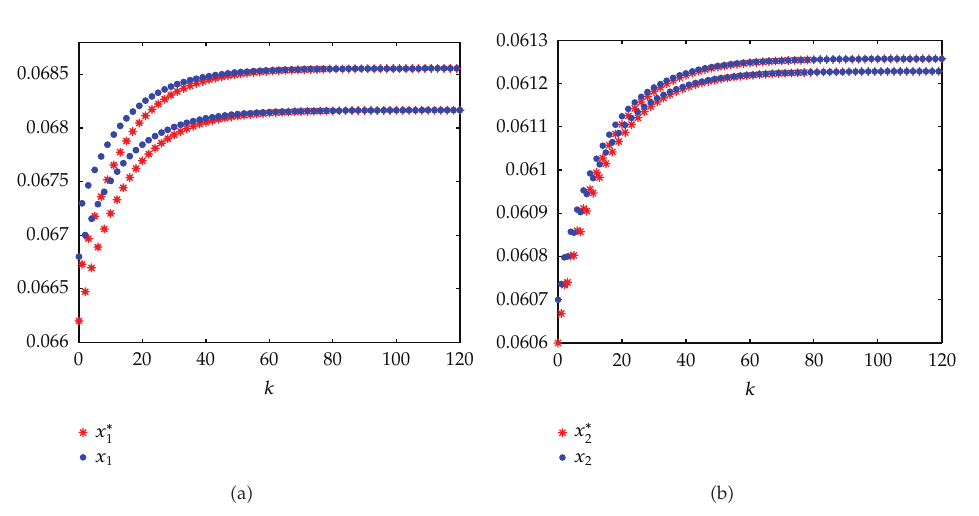
,x x ∗ ,x (cid:4) a (cid:7) Time series of x ∗ 1 and 2 . 2 1 (cid:4) 0 (cid:7) (cid:9) 0 . 0668. (cid:4) b (cid:7) Time series of x ∗ 1